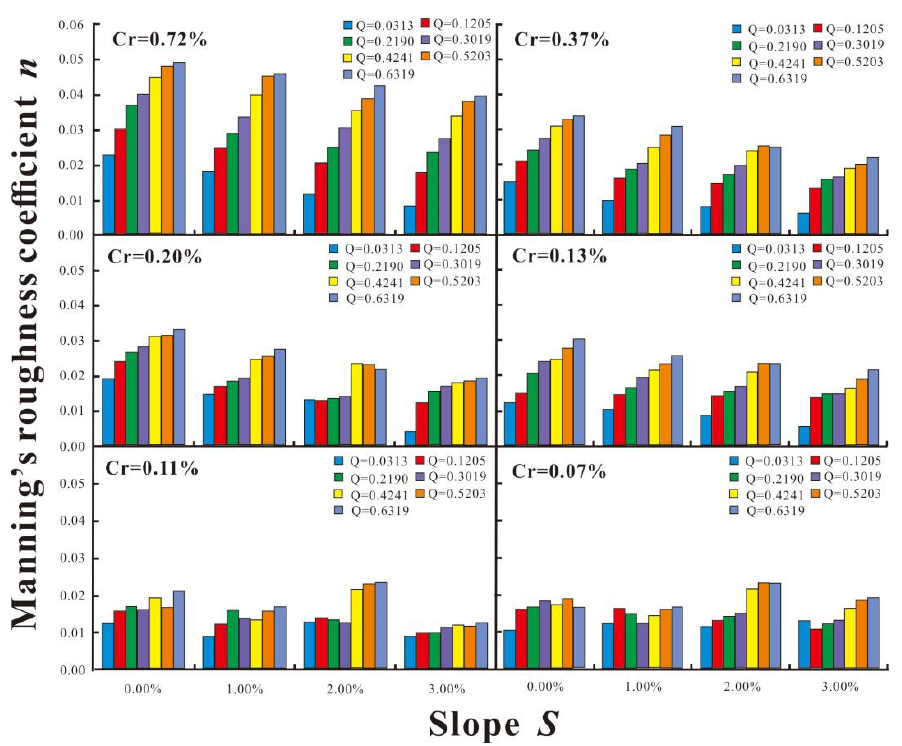
Figure 7. The relationship between Manning’s roughness coefficient ( n ) and slope gradient ( S ) under different flow discharge ( Q ) and stem cover ( Cr ) conditions. Stem cover range: 0.72, 0.37, 0.20, 0.13, 0.11, 0.07%; slope gradient range: 0, 1.0, 2.0, 3.0%; flow discharge range: 0.0313, 0.1205, 0.2190, 0.3019, 0.4241, 0.5203, 0.6319 m 3 /min.